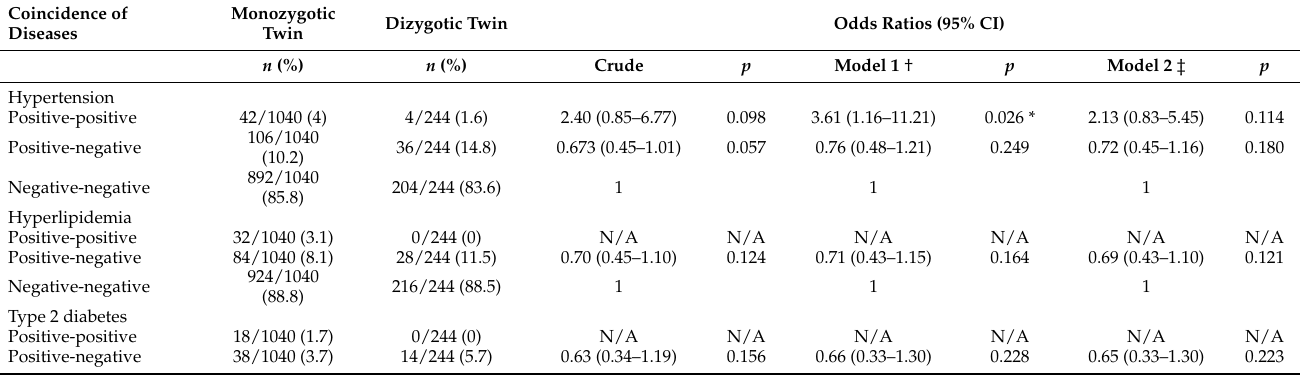
Table 3. Analysis of odds ratios with 95% confidence interval of occurrence of at least one cardio- metabolic disease of monozygotic twin compared to dizygotic twin (reference: negative/negative of diseases between